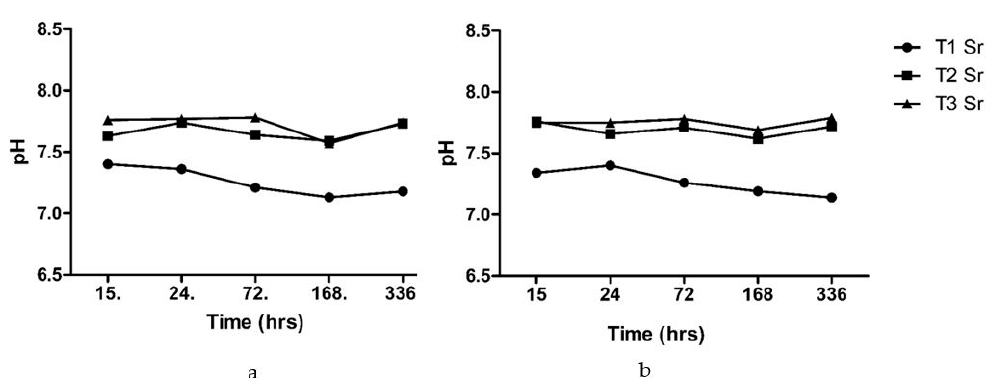
Figure 8. The changes in the pH after the immersion of T1 (pure alginate), T2 (alginate and